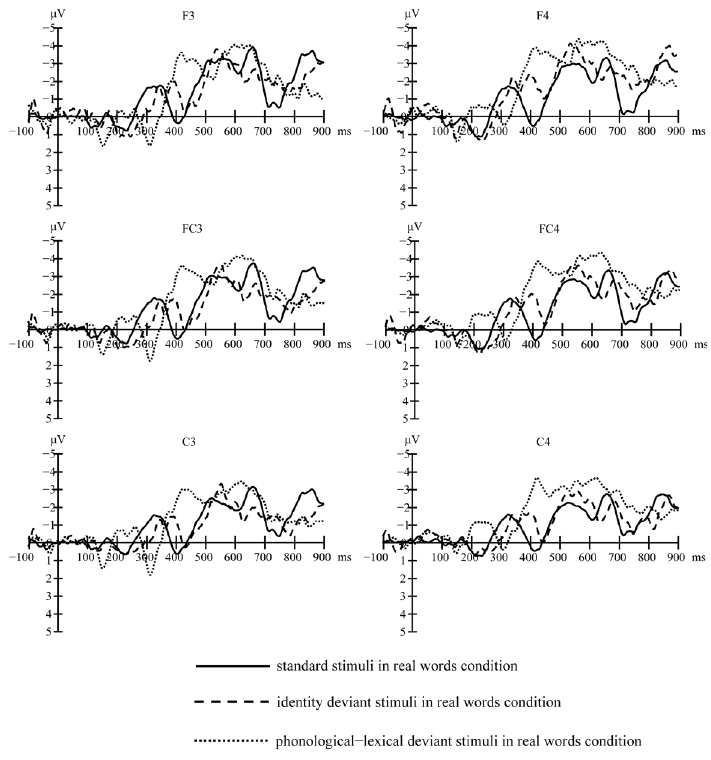
Figure 1. Grand-average waveforms evoked by the standard and deviant stimuli in real words’ condition at electrode locations F3, F4, FC3, FC4, C3, and C4.